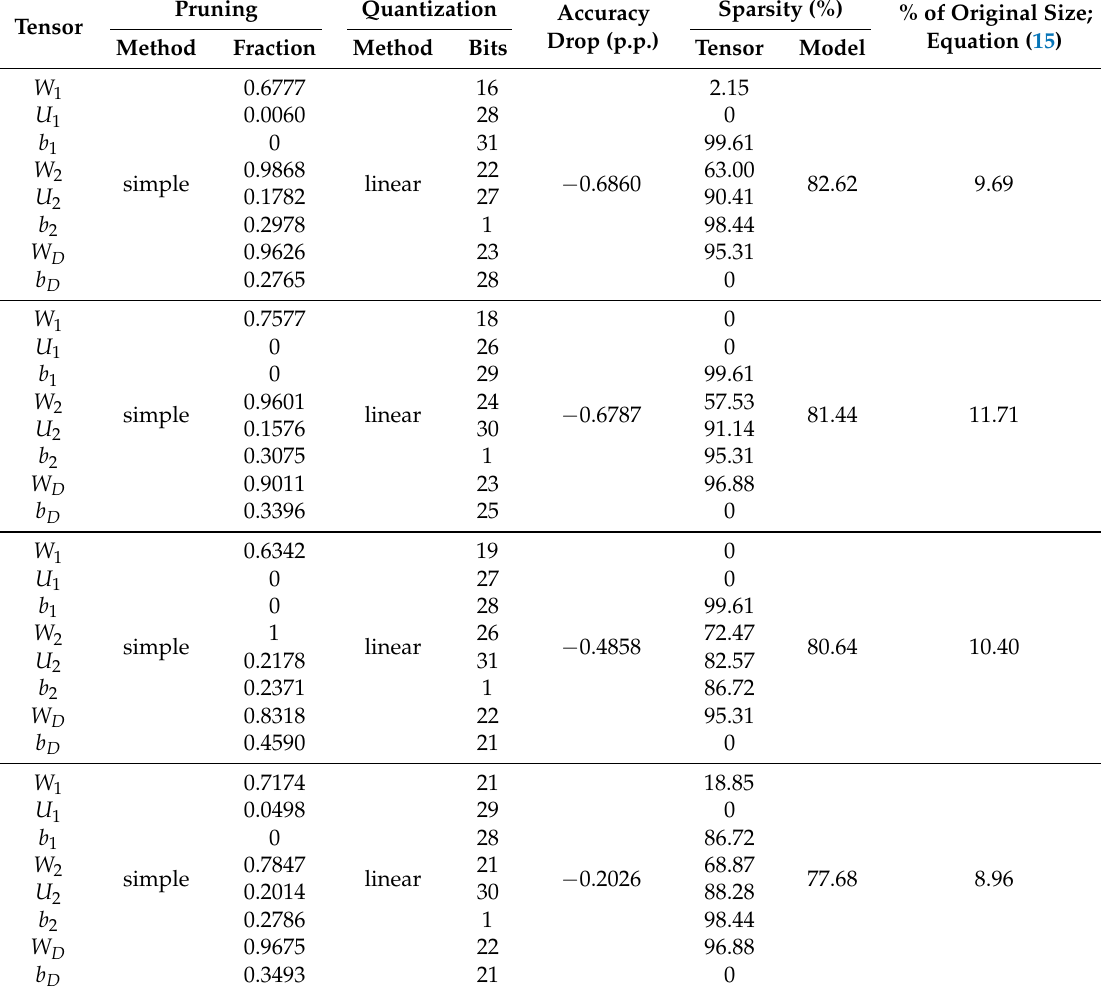
Table A8. [LHC] Results for model trained on bucketized data with individualized pruning and quantization